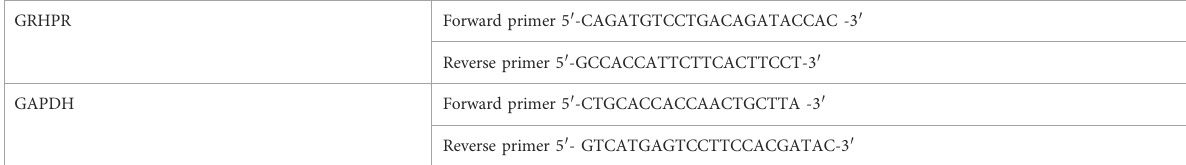
TABLE 1 Primer for RTqPCR.